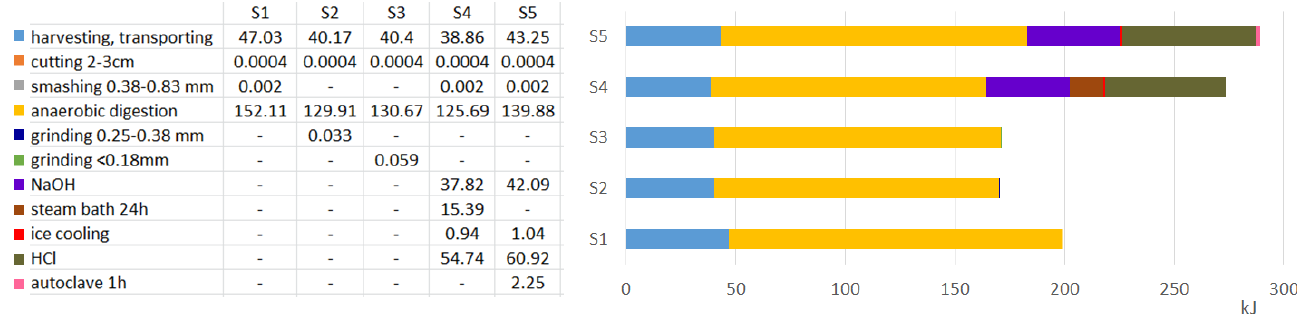
Figure 2. Cumulative Energy Demand per 1 dm 3 of Produced Methane in S1 – S5 Processes.